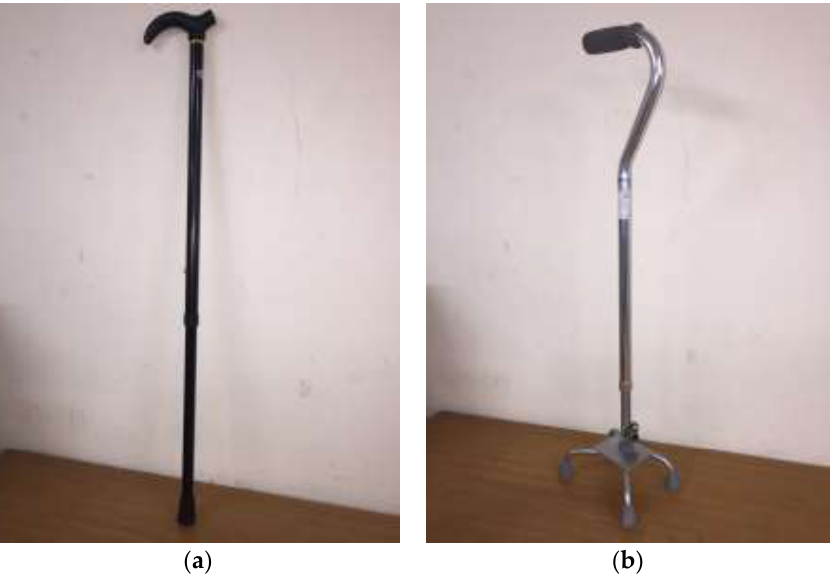
Figure 1. Two basic types of cane: ( a ) Standard cane; ( b ) Quadripod cane.